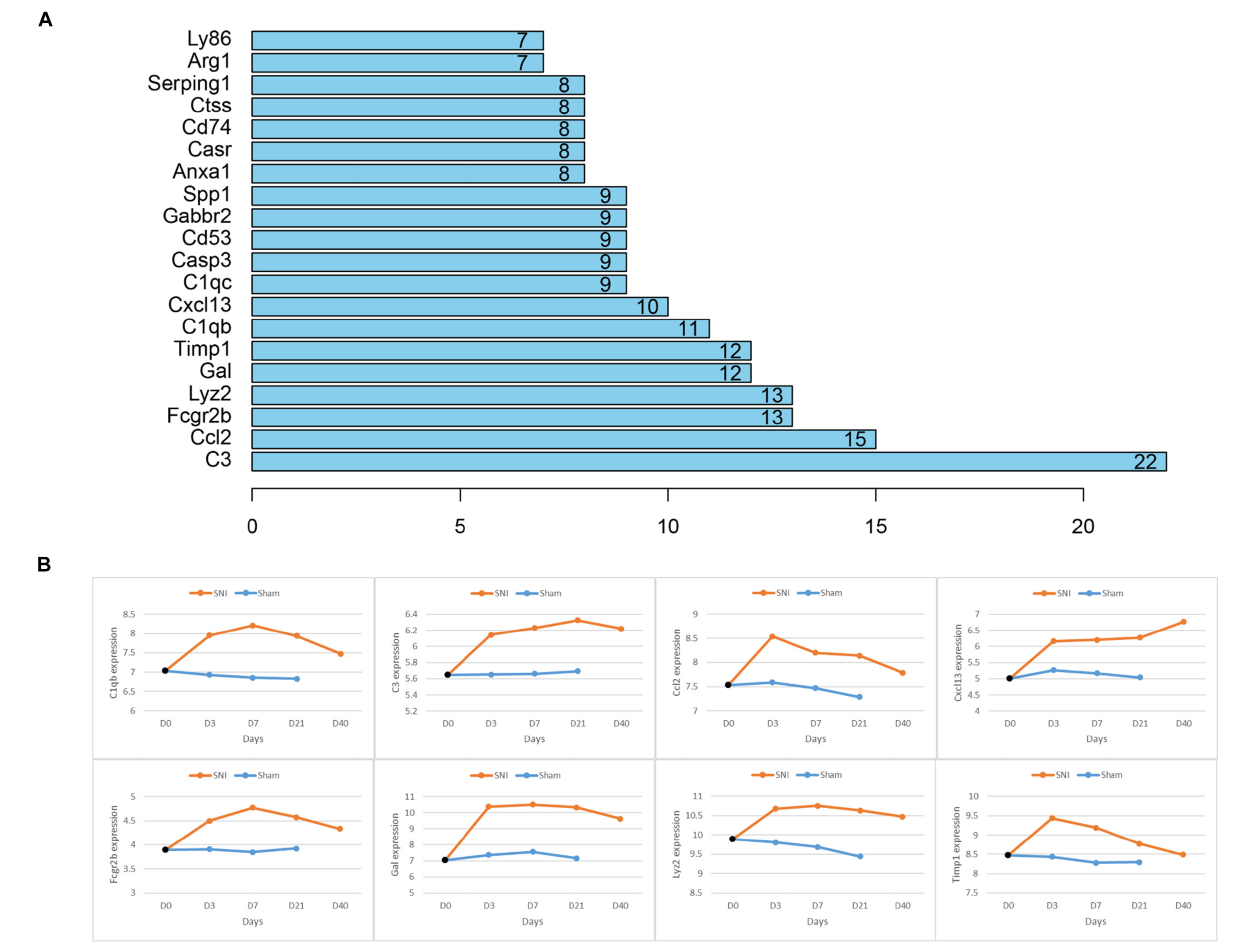
FIGURE 4 | Hub genes associated with NP and the relative expression of each hub gene in different time periods between SNI and Sham rats. (A) Node number of the hub genes in the PPI network; (B) the relative expression of each hub gene with a degree higher than 10 in different time periods between Sham and SNI rats.